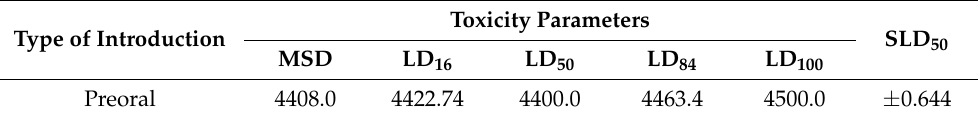
Table 2. Acute toxicity of oxidized Ag NPs stabilized with PVP with a single oral administration.